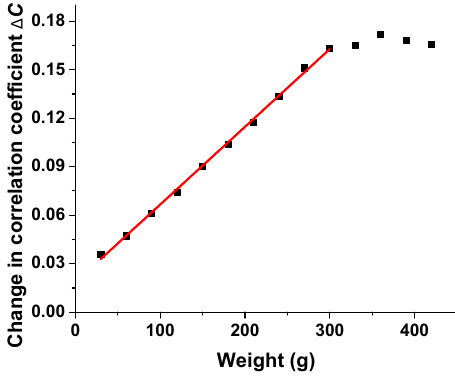
Figure 4. Sensing response for pressure change.